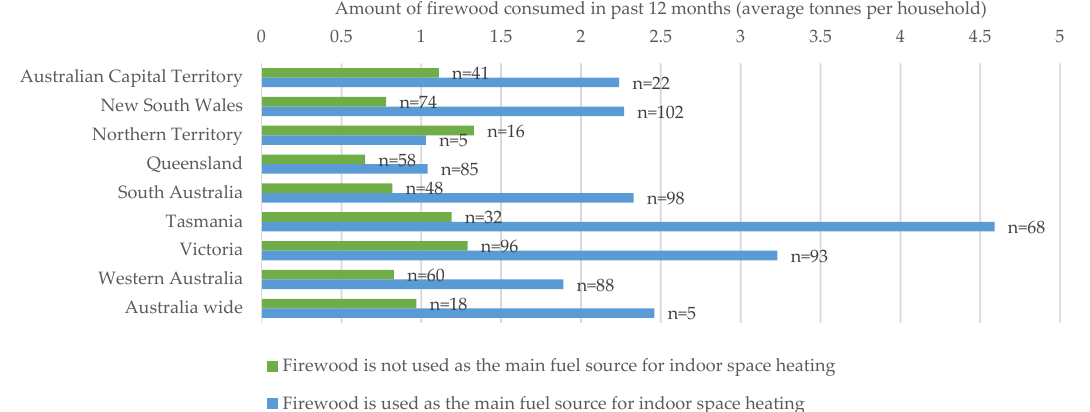
Figure 6. Average amount of firewood consumed per household in the past 12 months in each Australian state and territory (n = 986).